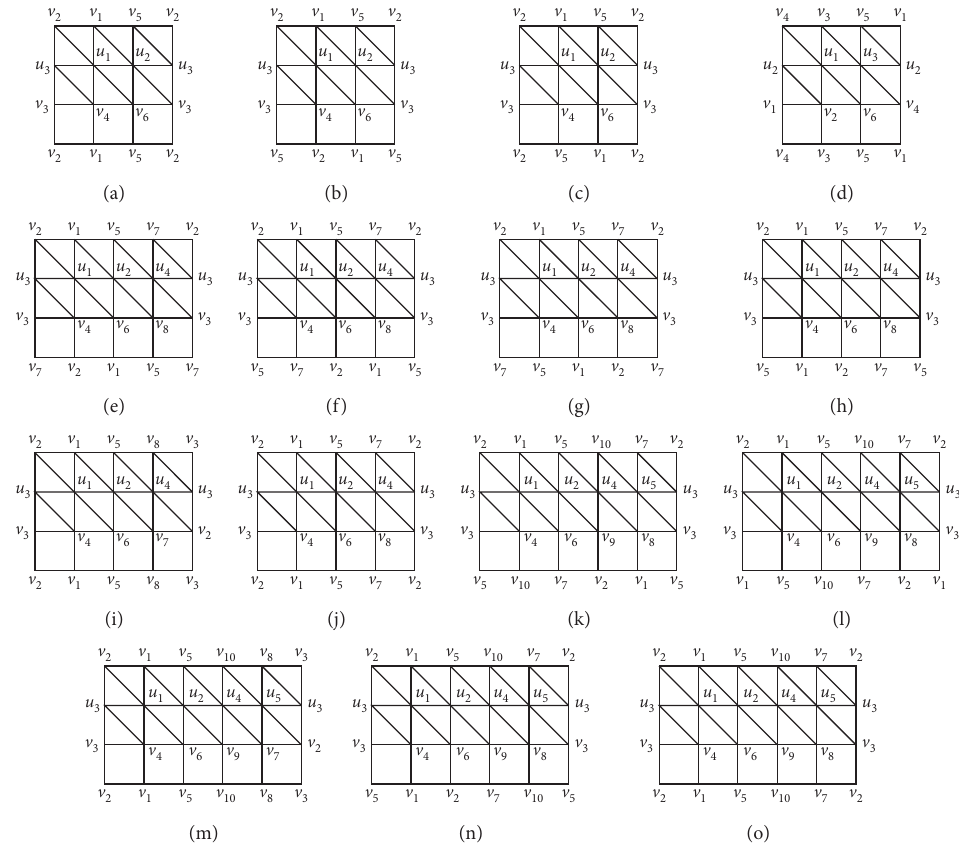
Figure 3: Doubly semiequivelar maps on torus and Klein bottle of type [ 3 6 : 3 3 , 4 2 ] . (a) T 1(3, 6) [3 6 : 3 3 , 4 2 ] 1 . (b) T 2(3, 6) [3 6 : 3 3 , 4 2 ] 1 . (c) K 1(3, 6) [3 6 : 1 3 3 , 4 2 ] 1 . (d) K 2(3,6) [3 6 : 3 3 , 4 2 ] 1 . (e) T 3(4,8) [3 6 : 3 3 , 4 2 ] 1 . (f) T 4(4,8) [3 6 : 3 3 , 4 2 ] 1 . (g) K 3(4,8) [3 6 : 3 3 , 4 2 ] 1 . (h) K 4(4,8) [3 6 : 3 3 , 4 2 ] 1 . (i) K 5(4,8) [3 6 : 3 3 , 4 2 ] 1 . (j) T 5(4,8) [3 6 : 3 3 , 4 2 ] 1 . (k) T 6(5,10) [3 6 : 3 3 , 4 2 ] 1 . (l) T 7(5,10) [3 6 : 3 3 , 4 2 ] 1 . (m) K 6(5,10) [3 6 : 3 3 , 4 2 ] 1 . (n) K 7(5,10) [3 6 : 3 3 , 4 2 ] 1 . (o) T 8(5,10) [3 6 : 3 3 , 4 2 ] 1